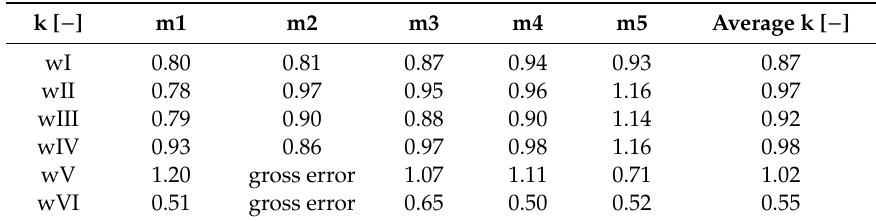
Table 10. Correction coe ffi cients for dielectric constants determined based on the wave amplitude reflected from the surface.